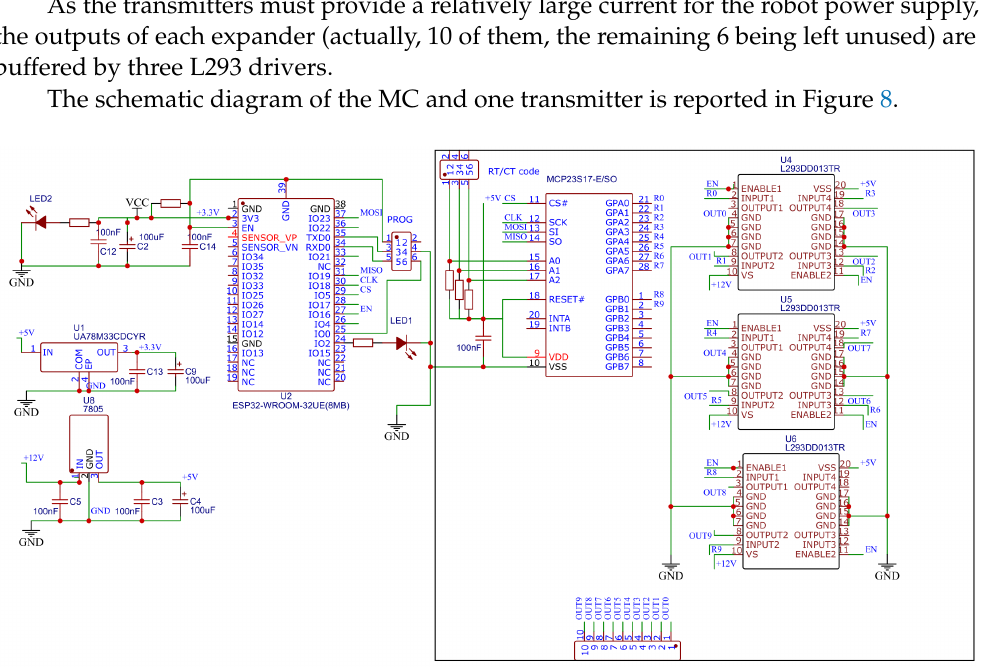
Figure 8. Schematic diagram of the main controller (on the left) and its connection to one of the transmitters (within the rectangle).